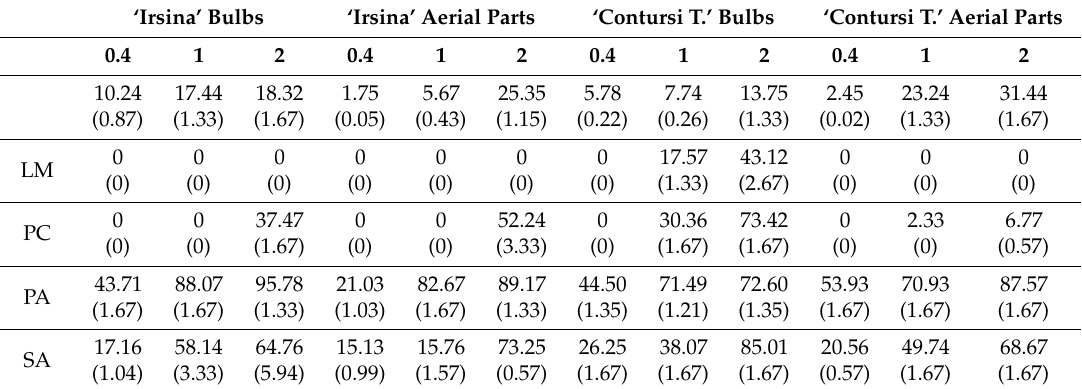
Table 3. Percent inhibition of the adhesion of bacterial cells caused by the extracts of bulbs and aerial parts of ‘Irsina’ and ‘Contursi T.’ landraces. The data are expressed as percentage respect to the control (value 0). Results are the mean of three experiments ( ± SD). EC: E. coli ; LM: L. monocytogenes